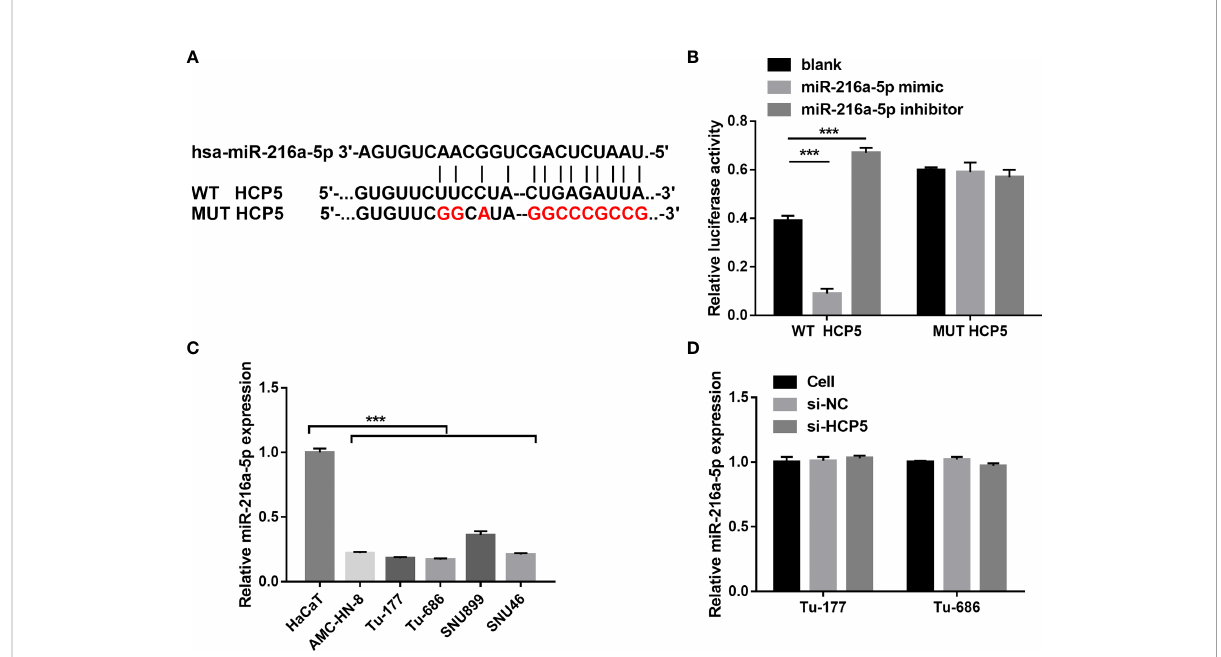
FIGURE 3 HCP5 served as a sponge for miR-216a-5p. (A) Bioinformatic analysis predicted the binding sites between HCP5 and miR-216a-5p. (B) A dual- luciferase reporter assay indicated that HCP5 directly bound to miR-216a-5p. (C) miR-216a-5p expression in LSCC cell lines and normal keratinocytes HaCaT was measured by RT-qPCR. (D) Effect of silenced HCP5 on the miR-216a-5p expression in LSCC cell was measured by RT-qPCR. n =3, ***p